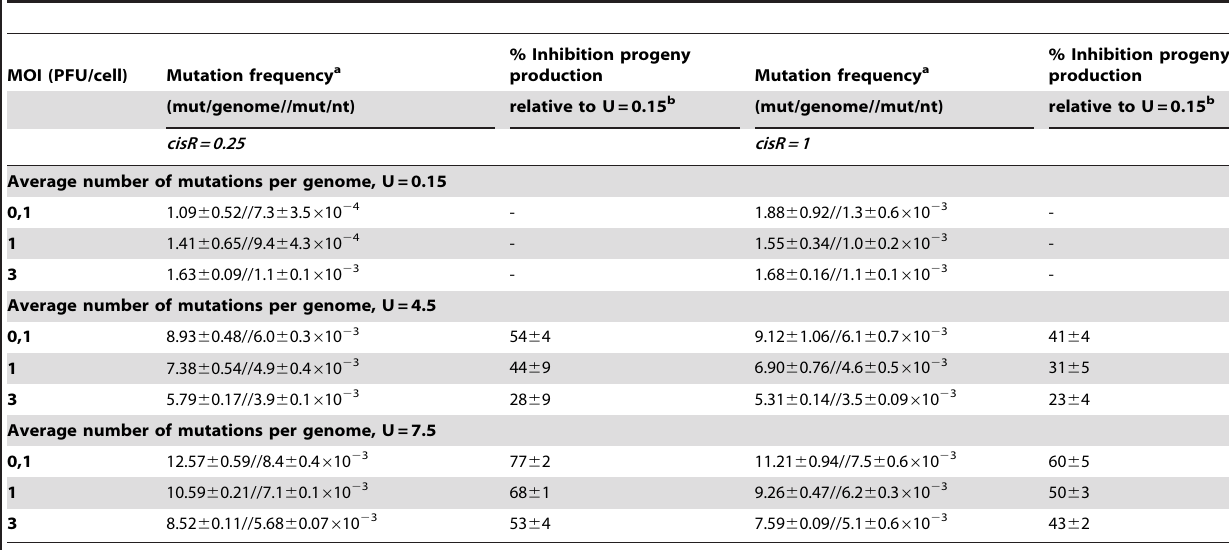
Table 3. Computer simulations of the mutation frequency and percentage of inhibition of viral infectious progeny production, as a function of the multiplicity of infection (MOI) and of the cis - trans interactions.